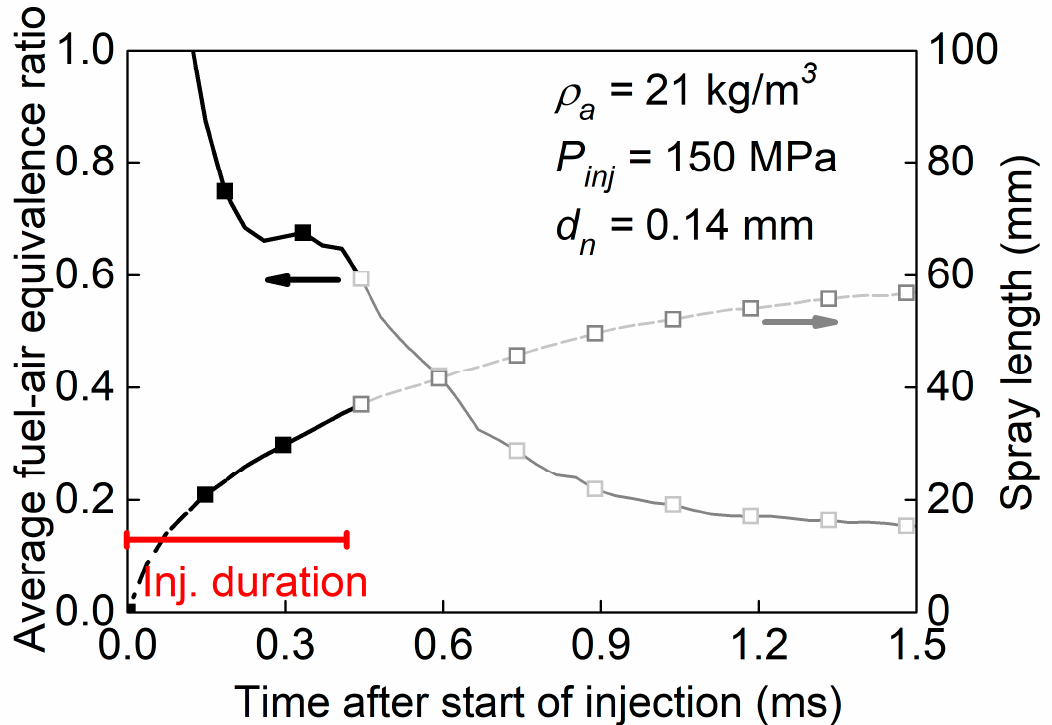
Figure 19. The spray length and equivalent ratio of fuel to air when applying the pilot-injection